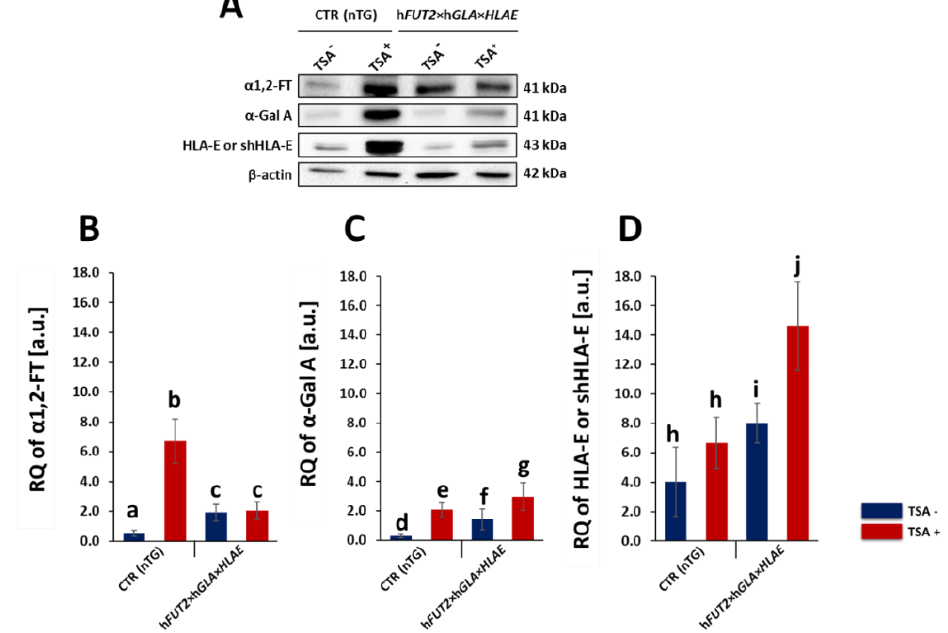
Figure 1. Western blot analysis of the relative expression of human α 1,2-fucosyltransferase ( α 1,2-FT), α -galactosidase A ( α -Gal A) and human leukocyte antigen-E (HLA-E) proteins in porcine triple-transgenic and non-transgenic ACFCs epigenetically transformed or not transformed with trichostatin A (TSA + and TSA − , respectively). Representative blots of the expression of α 1,2-FT, α -Gal A and HLA-E proteins in the ACFC samples derived from epigenomically modified (TSA + ) and non-modified (TSA − ) groups—panel ( A ). The samples stemming from non-transgenic pigs served as a control group (CTR nTG)—panel ( A ). β -Actin provided a loading control for all the analyzed samples. The results of relative expression (in arbitrary units) of α 1,2-FT, α -Gal A and HLA-E or swine homolog of HLA-E (shHLA-E) are shown in panels ( B – D ), respectively. The relative optical density (ROD) from three separate analyses of at least three animals for each variant is expressed as mean. The bar graphs show the mean ± SEM. Statistics: one-way ANOVA and Newman–Keuls post hoc test. The bars marked with different letters vary significantly; values denoted as a-b, b-c, e-g: p < 0.01; a-c, d-e, e-g, f-g, h-i, h-j, i-j: p < 0.05.